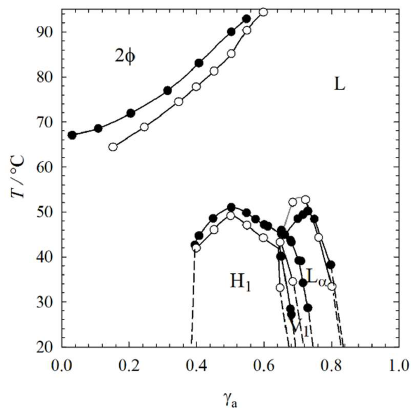
Figure A1. T –γ a phase diagrams of the binary systems H 2 O–C 12 E 7 (black circles) and D 2 O–C 12 E 7 (open circles). The phase transition temperatures were determined by visual observation in water basins.